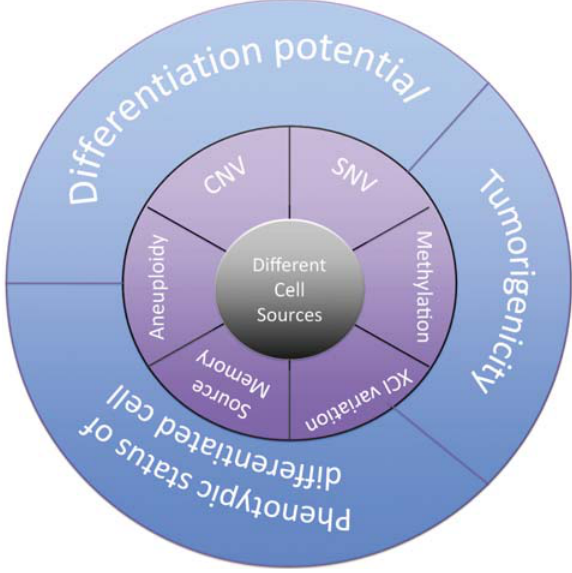
Figure 2. The epigenetic and genetic variations among different cell sources used for reprogramming can affect the properties of the iPSC and its differentiation to the target cell type. The characteristics of the different cell sources are at the core of defining how easily hiPSCs (human induced pluripotent stem cells) can be produced and their characteristics. Variations in aneuploidy, subchromosomal copy number variations (CNV), single-nucleotide variations (SNV), methylation, X chromosome inactivation (XCI) and source memory in the different cell sources can affect the differentiation potential, tumorigenicity and phenotypic status of hiPSCs. Aneuploidy is an abnormality in chromosome number. It is estimated that 13% of hiPSC cultures have